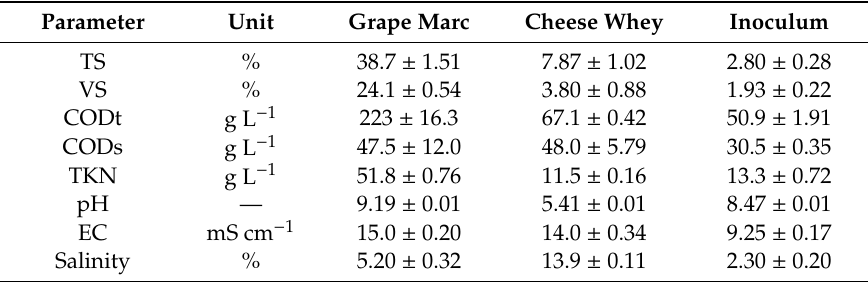
Table 3. Physicochemical composition of unmixed substrates and inoculum before digestion. Values recorded as mean ± standard error.